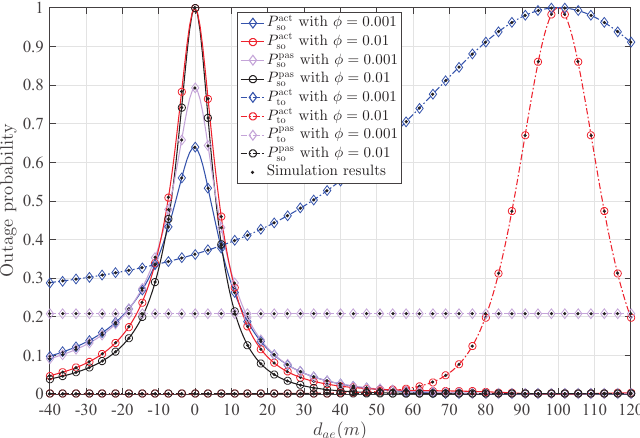
Figure 9. The influence of φ on the outage